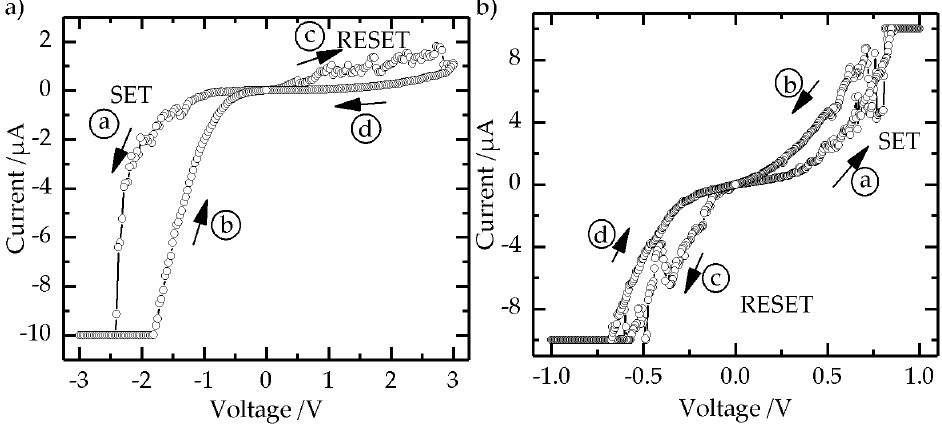
Figure 7. Two I–V curves recorded on different TiO 2 NP monolayers exhibiting bipolar resistive switching (BRS) behavior ( a , b ) (arrows and small letters depict voltage sweep sequence).